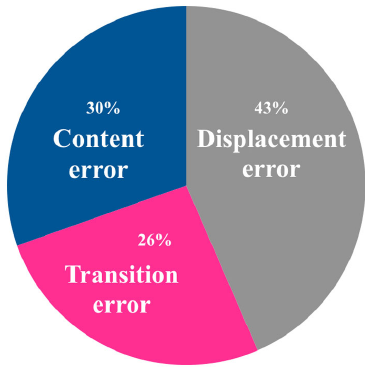
FIG. 8. Displacement, transition and content error categories of difficulty topics for questions that require transition. The total percentage is not 100 due to rounding